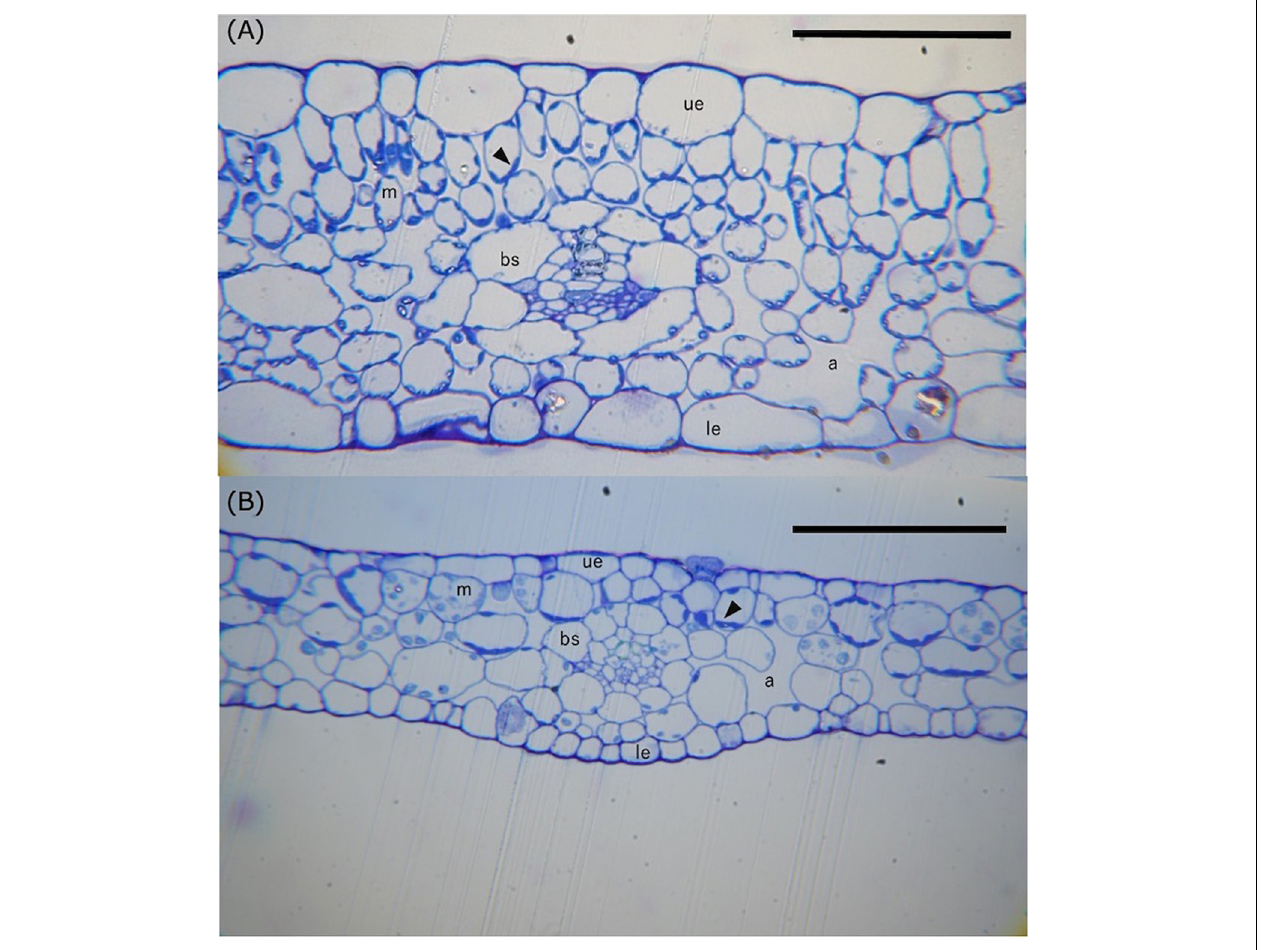
FIGURE 5 | Light photomicrographs of leaf cross sections of the terrestrial (A) and submerged (B) leaves of H. polysperma . Scale bars = 100 µ m. m, mesophyll cell; ue, upper epidermis; le, lower epidermis; bs, bundle sheath cell; a, air space. The arrowhead indicates the